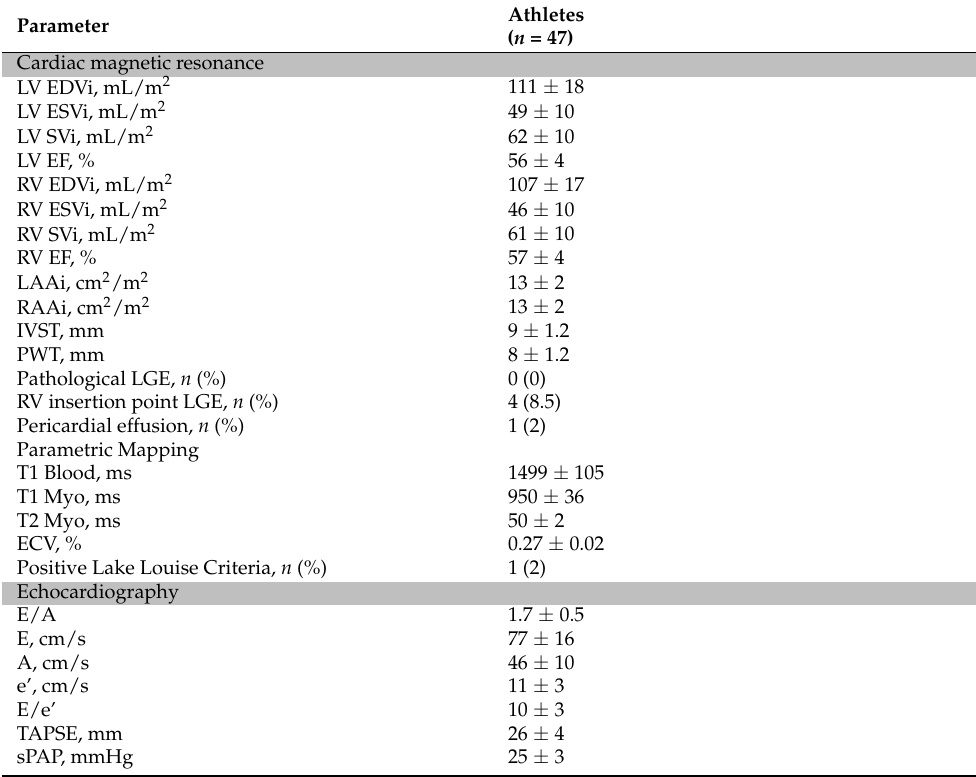
Table 3. Morphologic and functional cardiac